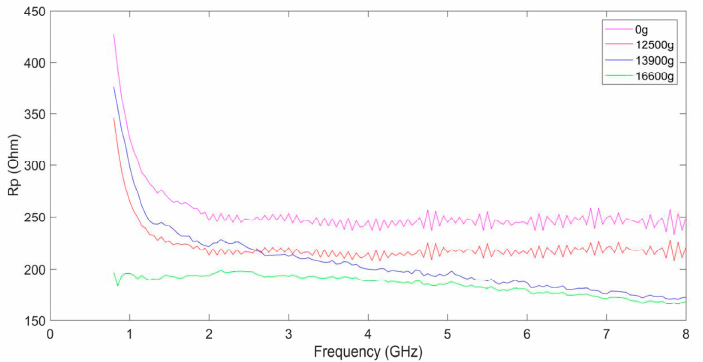
Figure 14. The parasitic resistance of the MEMS suspended inductors.